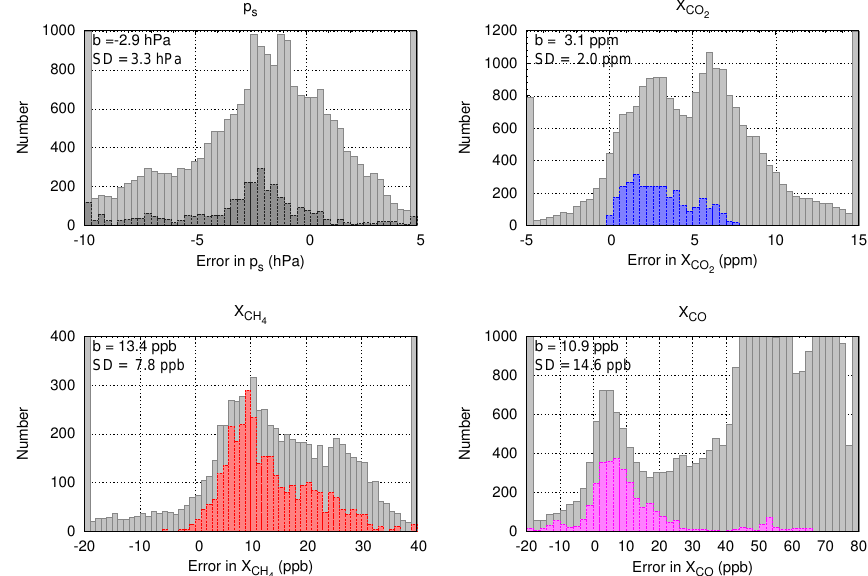
, X CH and X CO for experiment 2 with cloud-enabled and standard 2 4